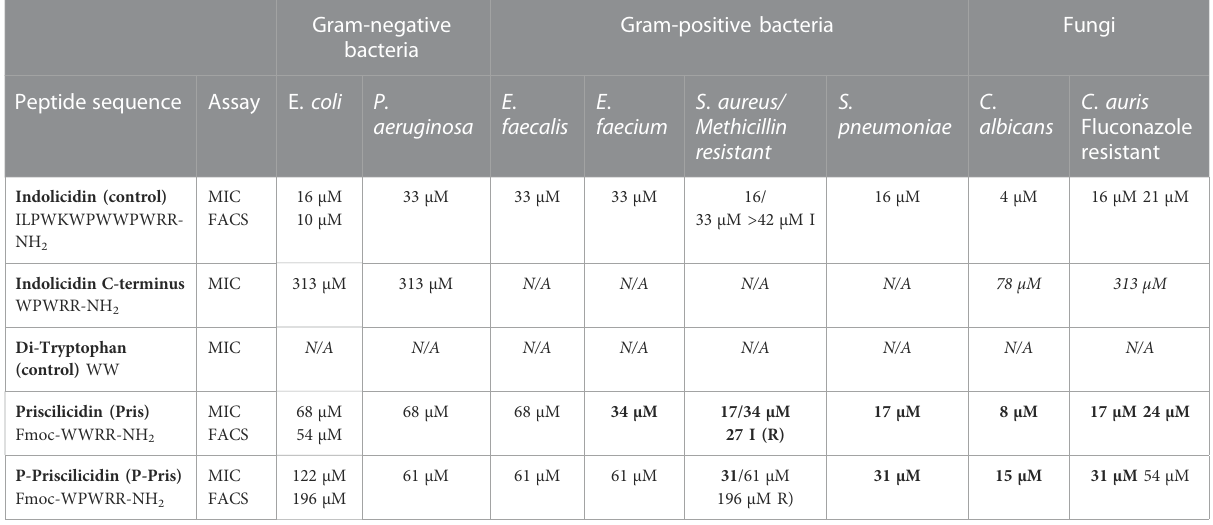
Table S1; Supplementary Figures S17 – S25). For peptide